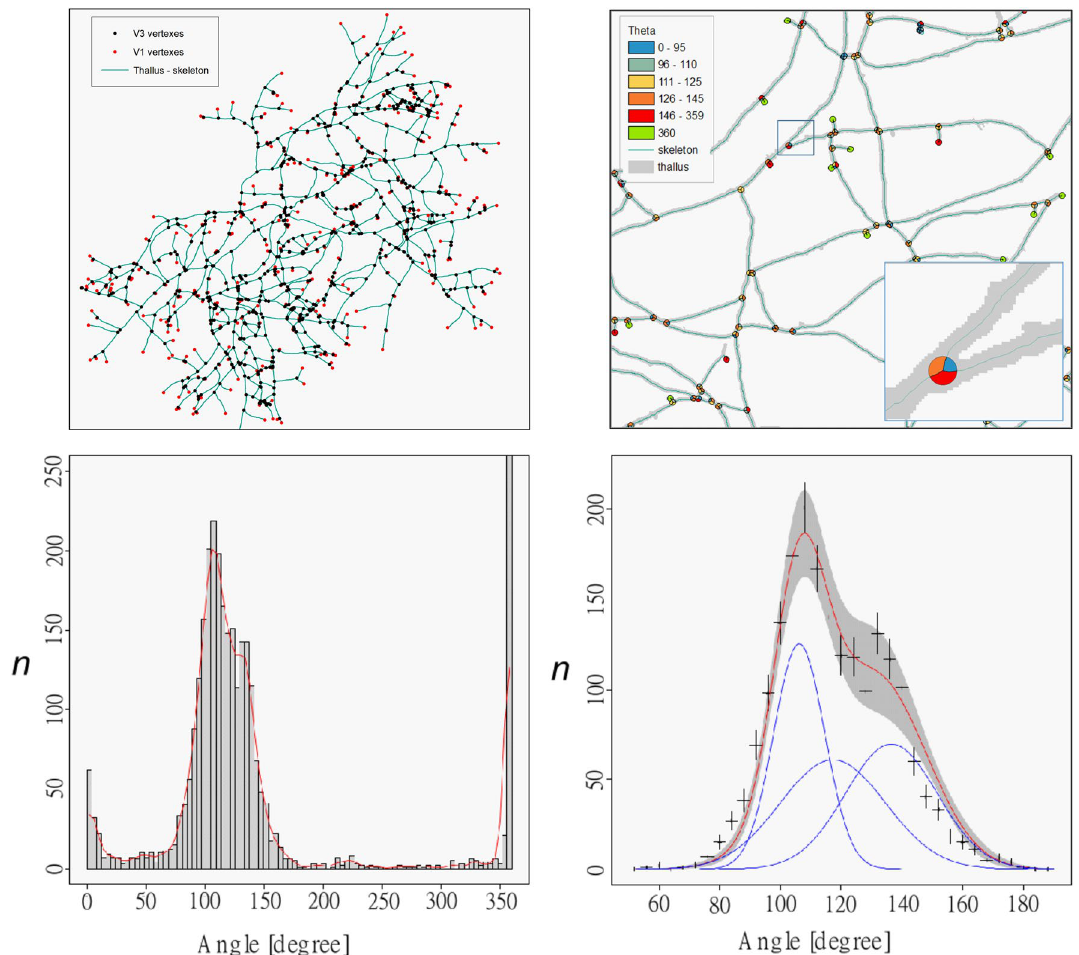
Figure 6. (Top-left) Skeletonization of the thallus, with identification of V 1 ob (red) and V 3 ob (black) vertices. (Top-right) Automatic calculation of angles from five-pixel buffers around vertices. (Bottom-left) Total angular spectrum with GIS method of the vertices (four populations, three angles from V 3 ob vertices and one V 1 ob vertices). (Bottom-right) Zoom in the range of interest. In blue, the three Gaussian distributions. In red the normalised sum of the three Gaussians. In grey, range of one-standard deviation derived from the